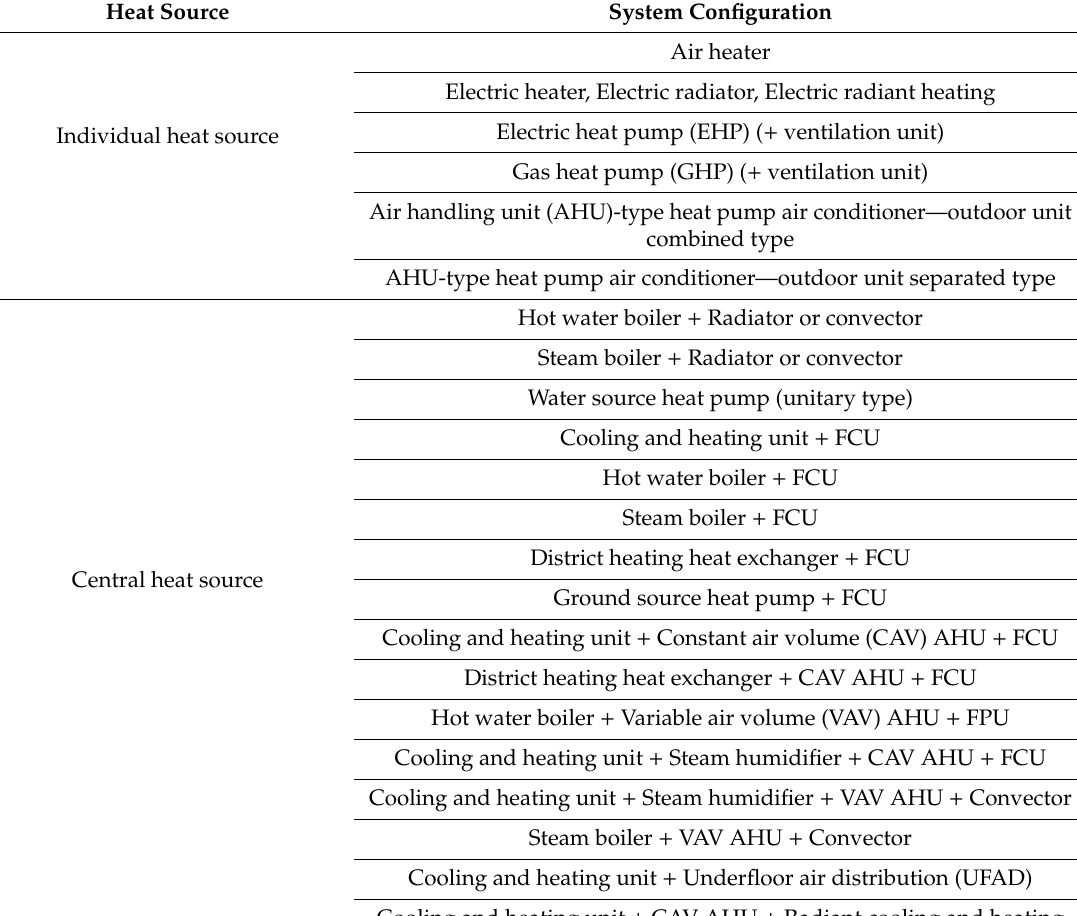
Table A1. Examples of space heating